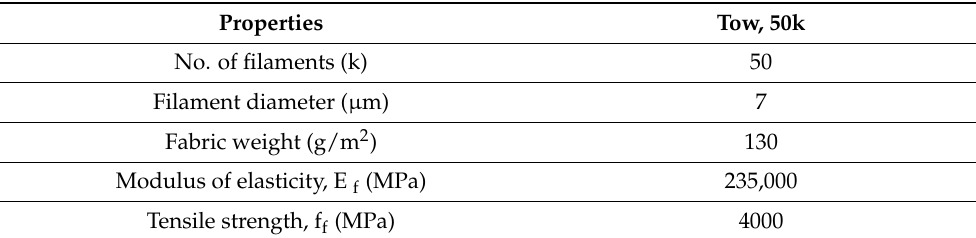
Figure 1. Multi-filament carbon fibres used as reinforcement of TRC beams. Table 1. Engineering properties of carbon textile reinforcements.